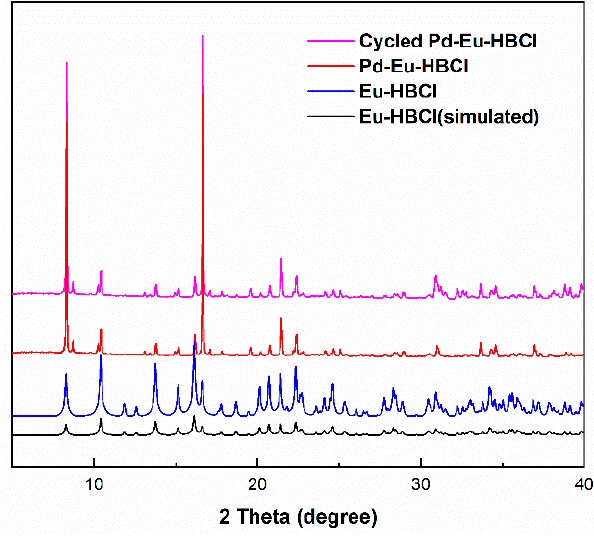
Figure 1. PXRD patterns of different samples.